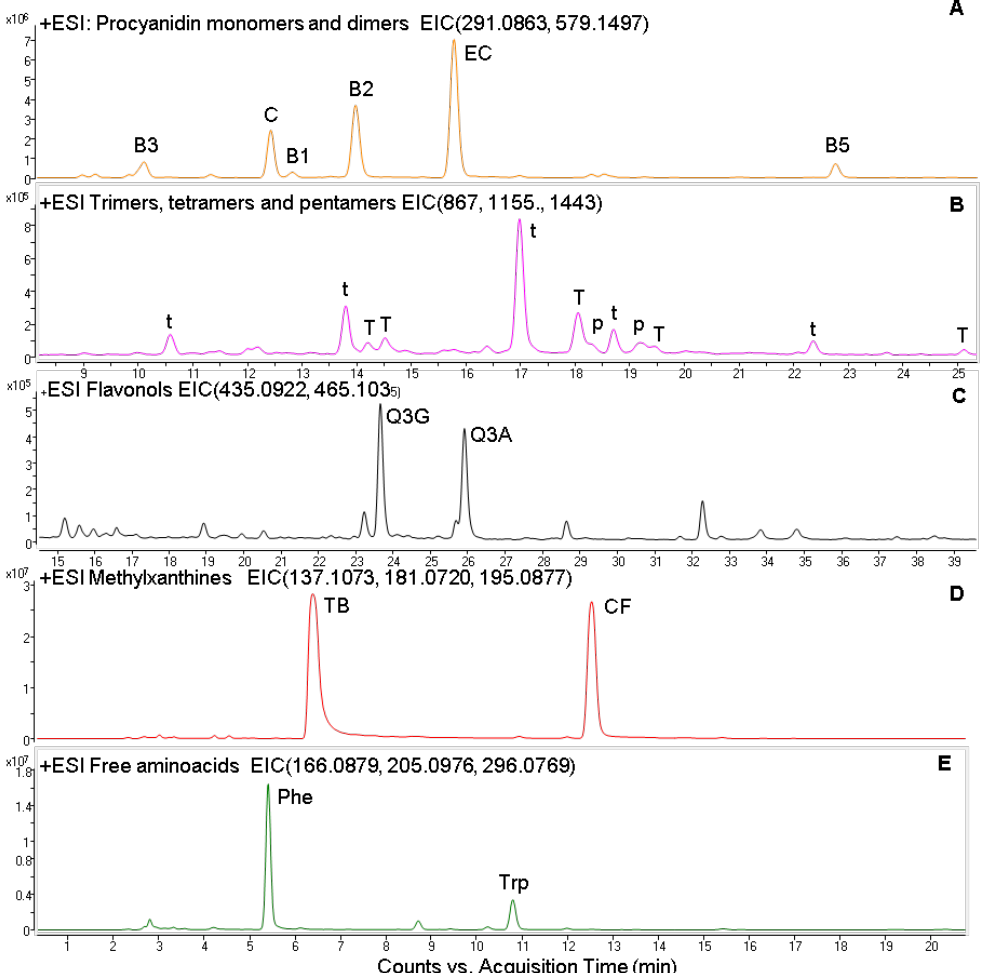
Figure 1. Extracted ion chromatogram (EIC) from the ESI positive analysis of Procyanidin monomers and dimers ( A ); trimers, tetramers, and pentamers ( B ); flavonols ( C ); methylxanthines ( D ) and free aminoacids ( E ). C, catechin; EC, epicatechin, B1, B2, B3, and B5 procyanidin dimers; t, procyanidin trimer; T, procyanidin tetramer; p, procyanidin pentamer; TB, theobromine; CF, caffeine; Phe, L -phenylalanine; Trp, L -tryptophan.